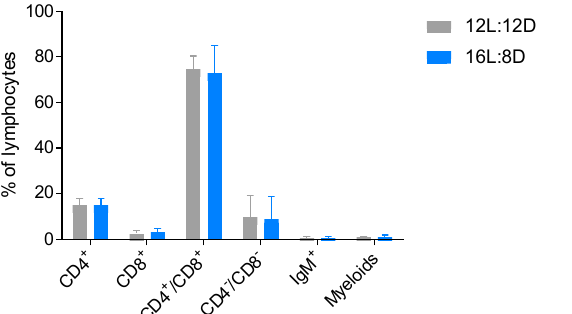
Figure 5. Cytometry analysis of T lymphocytes in the thymus of rainbow trout with a photoperiod of 12 h light/12 h darkness and 16 h light/8 h darkness. The graph shows the percentages of CD4/CD8 (DN, DP, SP), IgM (SP) and Myeloid cells (SP) in the thymus. Data are expressed as means ± SEM. N = 5.